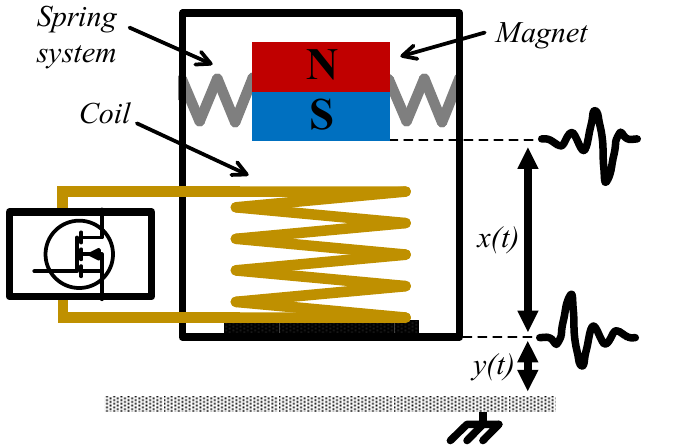
Figure 1. Schematic representation of a standard single coil resonant electromagnetic vibration energy harvester.